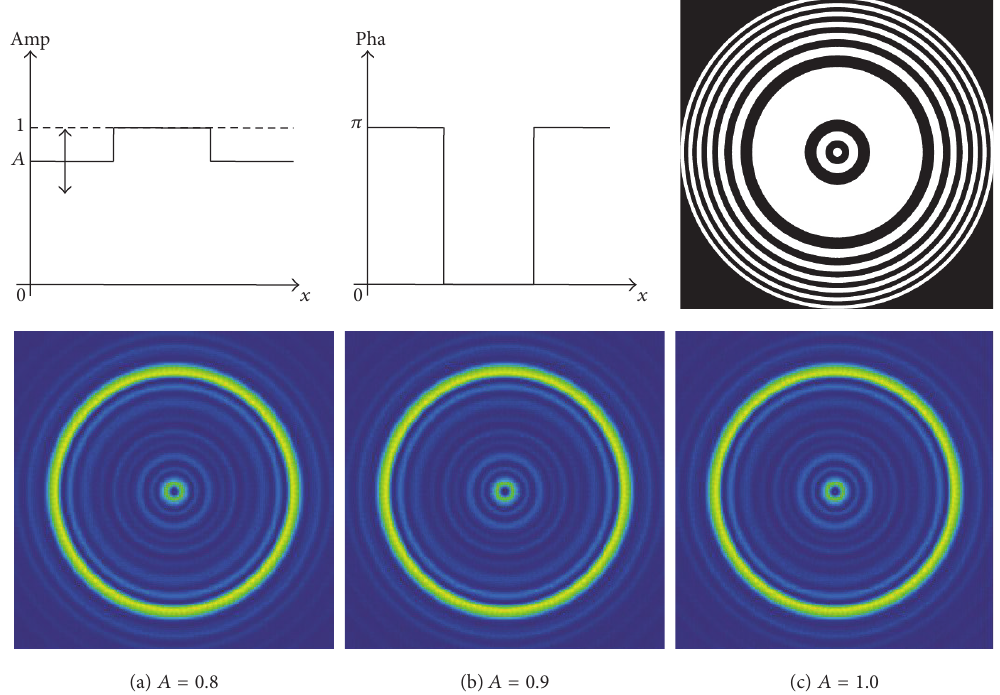
Figure 8: The simulation parameters (amplitude and phase diagrams together with the structure’sphase distribution). Intensity distributions (simulation results) for different material attenuation for ideal lens. Simulations were conducted for material attenuation values (1.0 value corresponds to no attenuation situation) as follows: 0.8, 0.9, and 1.0, shown in (a)–(c), respectively.